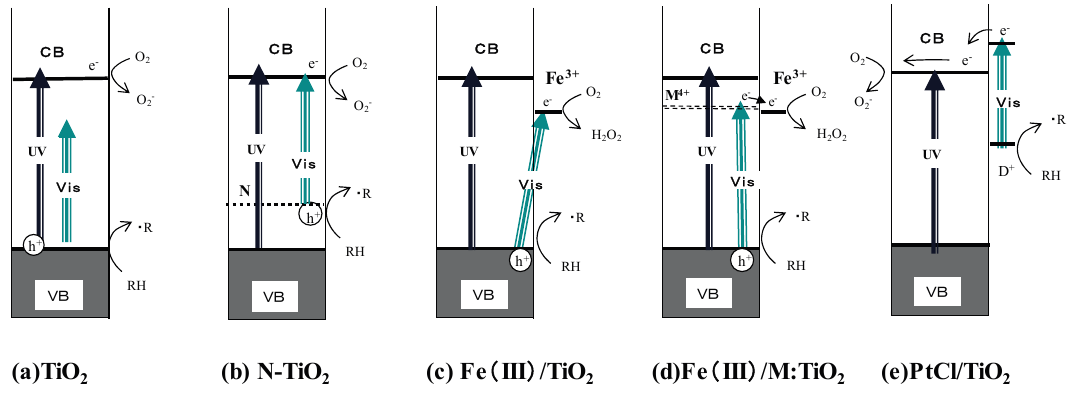
Figure 3. Classification of visible-responsive photocatalysts by the primary reaction mechanism. ( a ) Unmodified TiO 2 ; ( b ) Nitrogen doped TiO 2 ; ( c ) Fe(III) grafted TiO 2 ; ( d ) Fe(III) grafted metal doped TiO 2 ; ( e ) Platinum complex deposited TiO 2 . Adopted with permission from [18]. © 2013 American Chemical